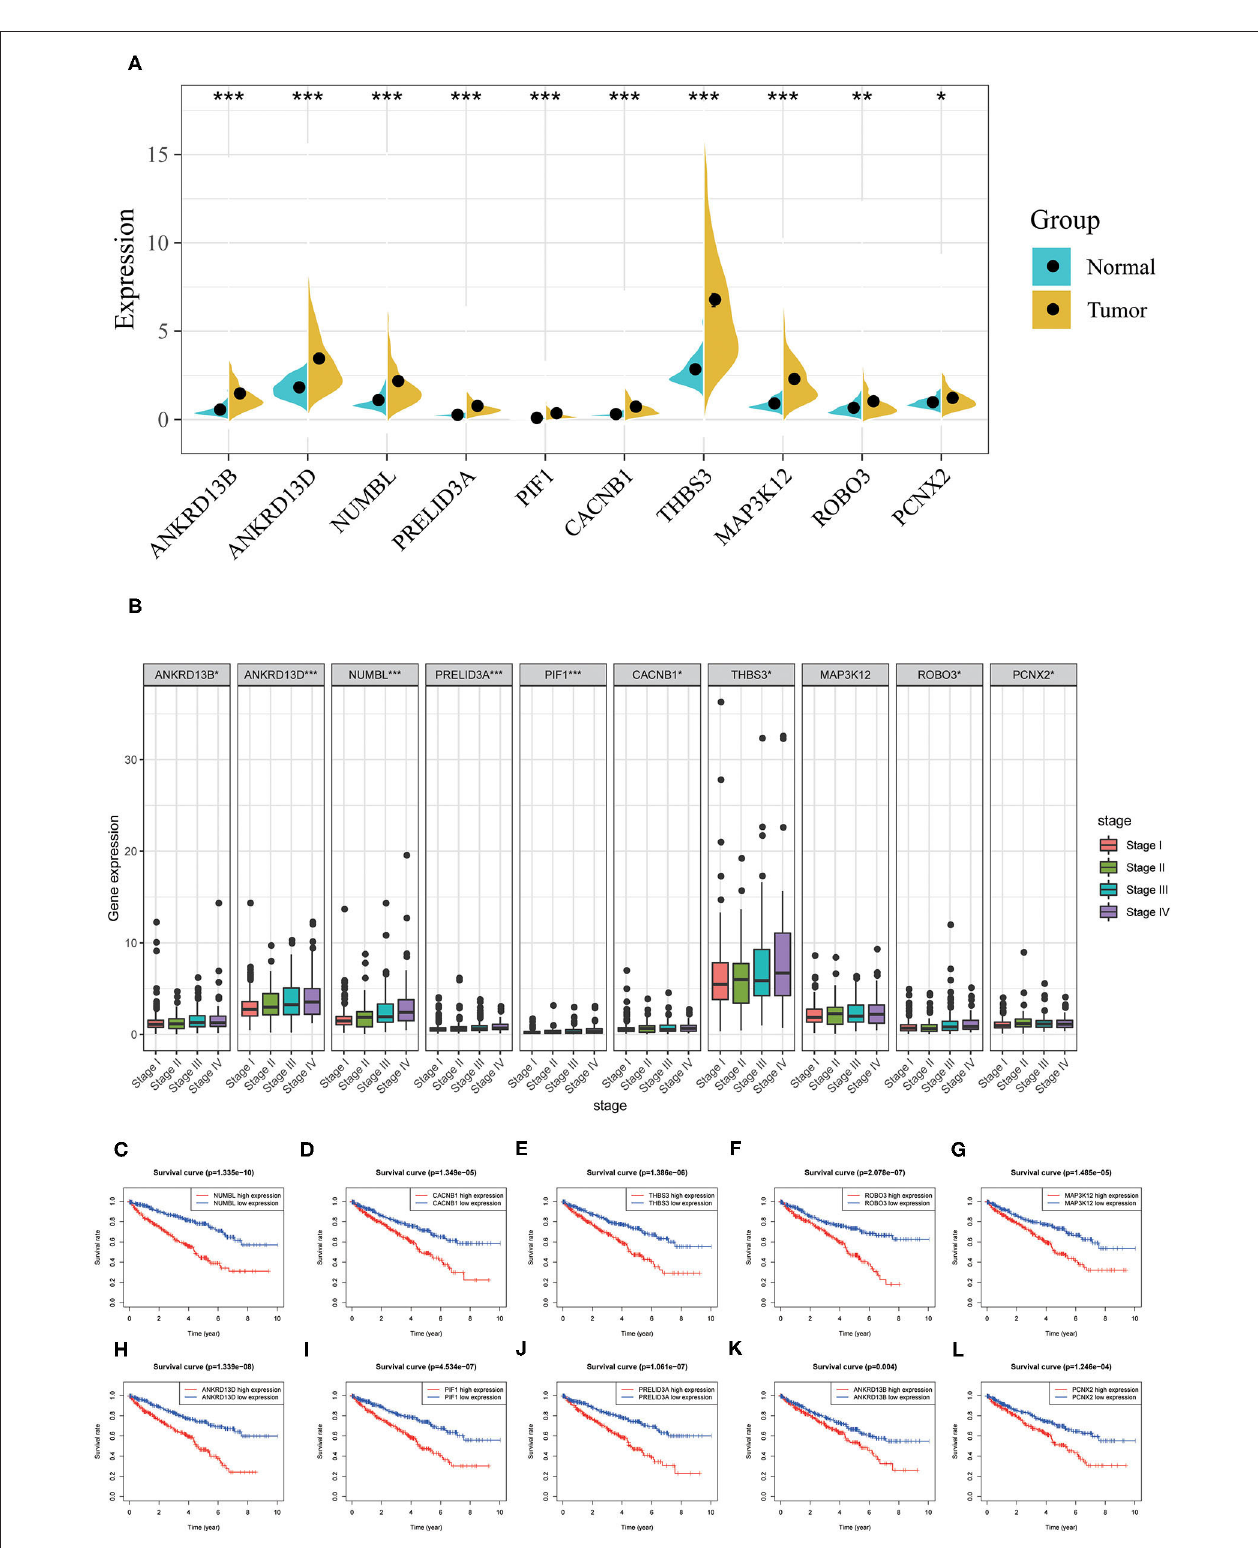
FIGURE 6 | Analyses of co-expressed genes with TRIM46. (A) NUMBL, CACNB1, THBS3, ROBO3, MAP3K12, ANKRD13D, PIF1, PRELID3A, ANKRD13B, and PCNX2 were overexpressed in ccRCC; (B) higher levels of NUMBL, CACNB1, THBS3, ROBO3, MAP3K12, ANKRD13D, PIF1, PRELID3A, ANKRD13B, and PCNX2 indicated advanced clinical stage for patients with ccRCC; (C–L) higher expression level of NUMBL, CACNB1, THBS3, ROBO3, MAP3K12, ANKRD13D, PIF1, PRELID3A, ANKRD13B, and PCNX2 indicated worse OS for patients with ccRCC (* p < 0.05, ** p < 0.01, *** p < 0.001).